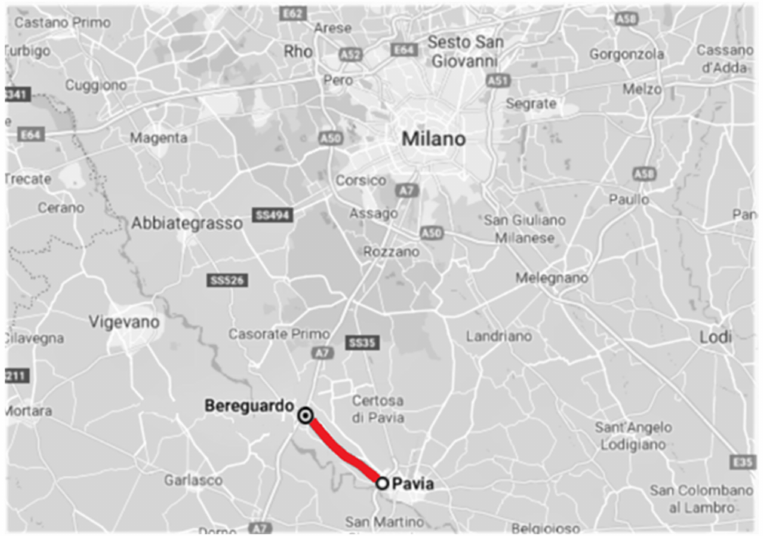
Figure 1. The location of the A53 motorway in the south of the metropolitan city of Milan.